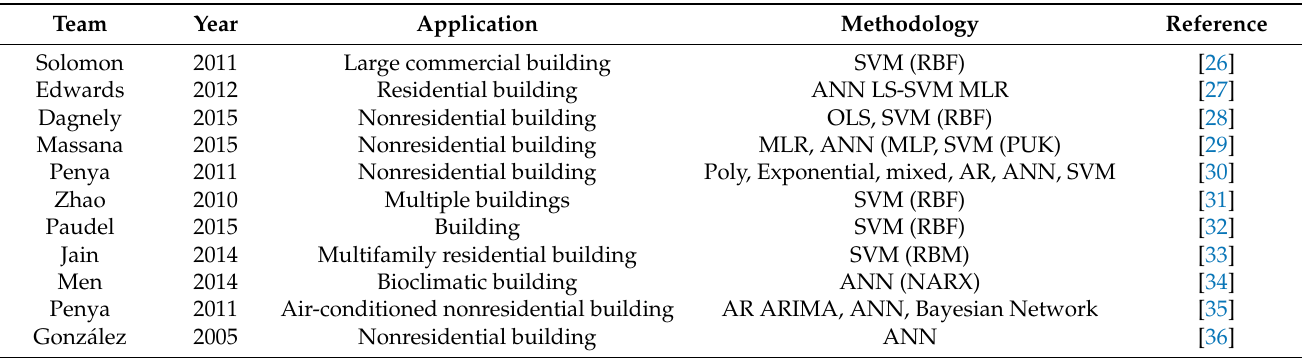
Table 1. Comparative study of energy